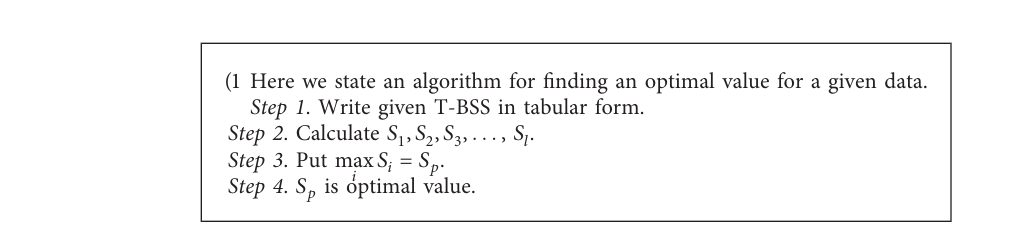
(1 Here we state an algorithm for finding an optimal value for a given data.